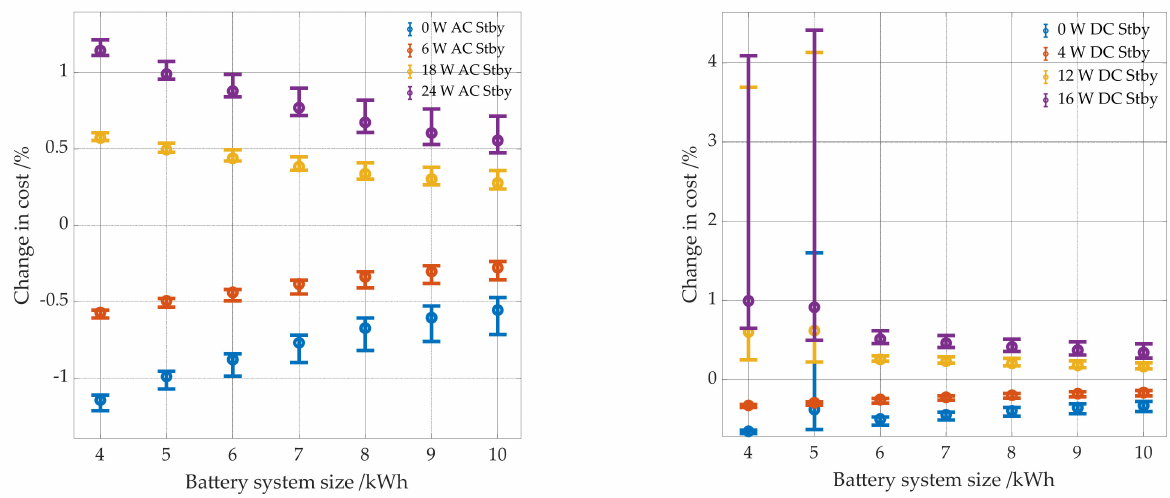
Figure 20. Change in electricity costs per kWh of the reference case to the simulations with a lower or higher AC standby consumption as a function of the battery system size ( left panel). Change in electricity costs per kWh of the reference case to the simulations with a lower or higher DC standby consumption as a function of the battery system size ( right